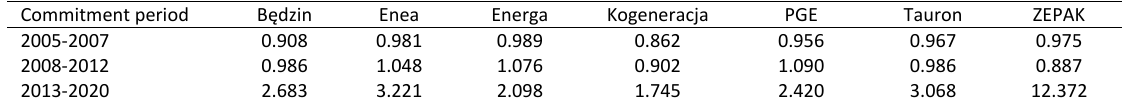
Table 1: Aggregated values of EA ratio for Polish energy groups in particular phases of the EU ETS Commitment period Będzin Enea Energa